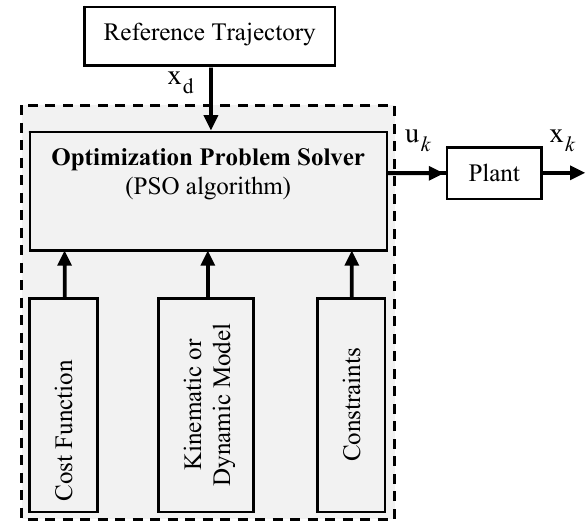
Figure 3. Block diagram of the proposed MPC-PSO